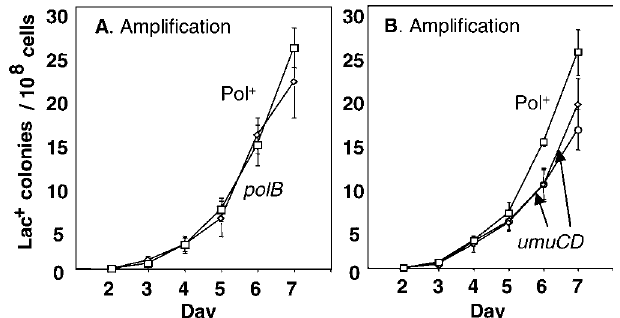
Figure 5. DNA Polymerases II and V Are Not Required for Adaptive Amplification (A) Deletion of polB, encoding Pol II, has no effect on amplification. The associated strains are as follows: Pol þ (squares), SMR4562; and polB (diamonds), SMR3661. (B) Deletion of umuCD has little or no effect on amplification. Results for two independent isolates are shown. Strains used are as follows: Pol þ (squares), SMR4562; and umuCD (diamonds and circles), SMR3525 and SMR3526. DOI: